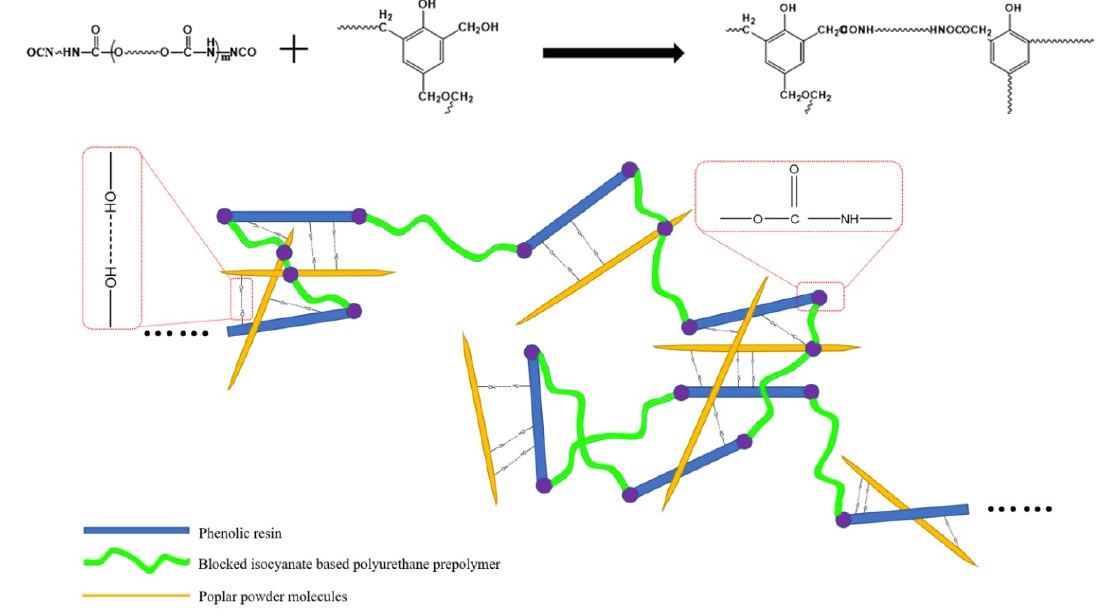
Figure 3. The mechanism of PU/poplar wood flour hybrid enhanced phenolic foam (PF).